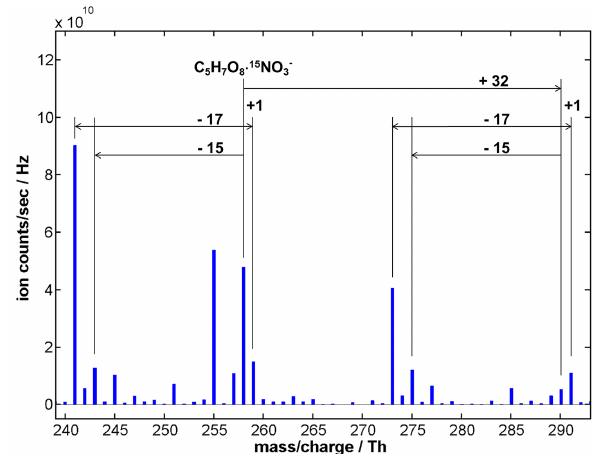
Figure 2. Spectrum of ozonolysis products of cyclopentene with dimer character. The detected elemental compositions are indicated and its termina- 3 (cf. Sect.